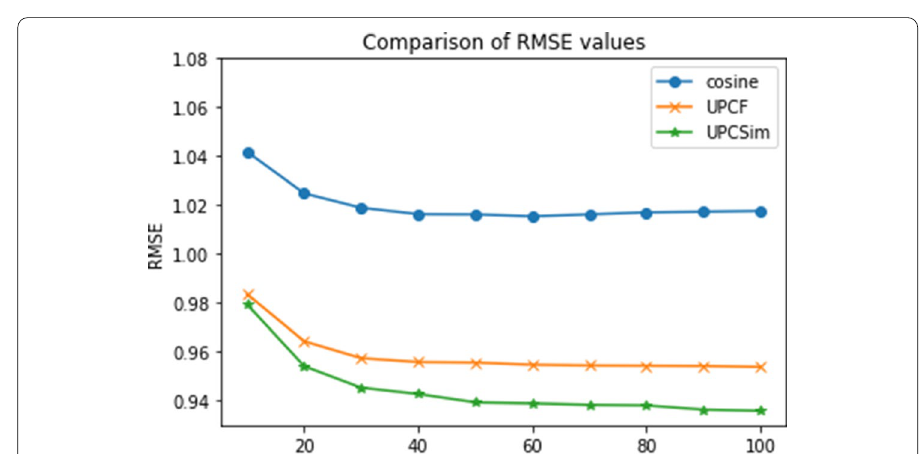
Fig. 4 Comparison of the average RMSE values of the three similarity algorithms using MovieLens 100K